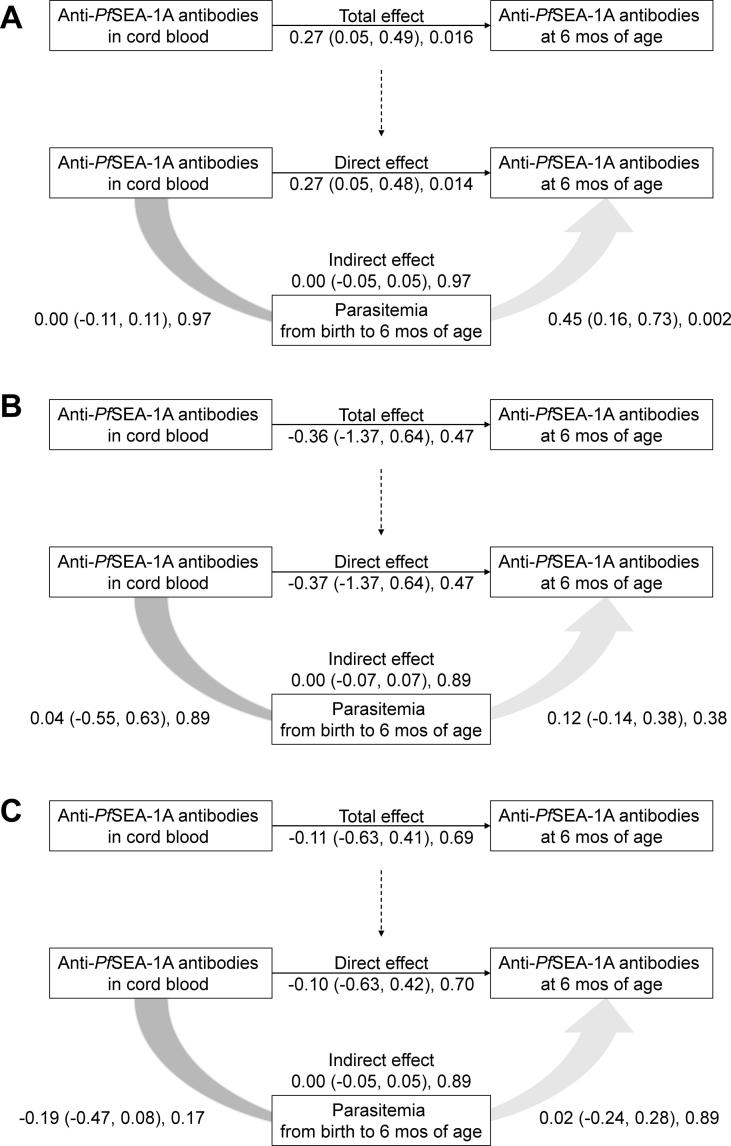
The relationship among cord blood anti-PfSEA-1A antibody levels, parasitemia, and anti-PfSEA-1A antibody levels at 6 months of age stratified by tertiles (A: low, B: middle, and C: high) of cord blood anti-PfSEA-1A antibody levels. Anti-PfSEA-1A antibody levels and parasitemia (asexual stage parasites/200 WBCs) were natural log-transformed. Numbers next to arrows indicate unstandardized coefficient (95% confidence interval), P value.